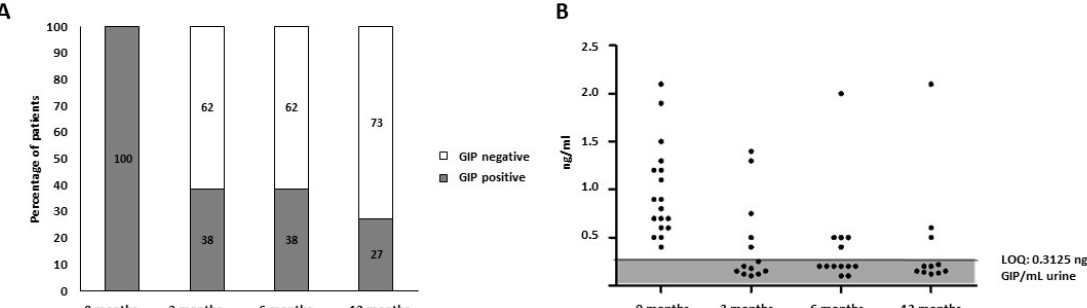
Figure 5. Concentration of urine GIP from patients with CD at the baseline visit and over 12 months after the initiation of a GFD. ( A ) Percentage distribution of the GFD-treated patients with CD according to GIP concentration. ( B ) GIP levels in urine at the basal and follow-up visits (basal, three, six, and 12 months). CD, celiac disease; GFD, gluten-free diet; GIP, gluten immunogenic peptides; LOQ, limit of quanti fi cation.